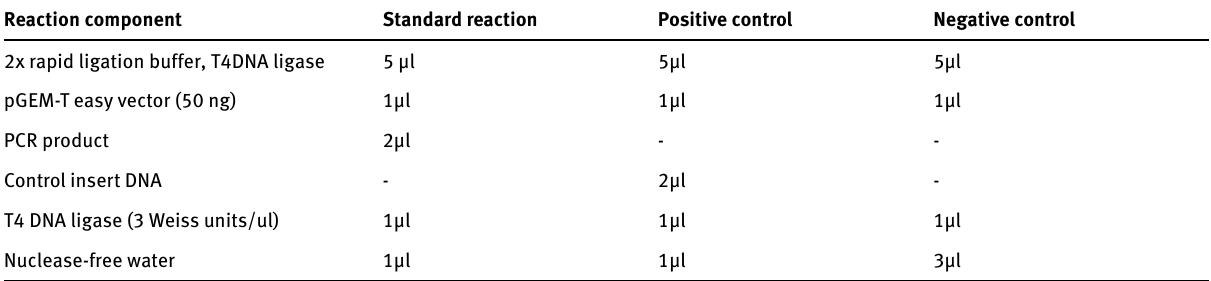
Table 3. Ligation reaction protocol to a final reaction volume of 10ul (pGEM®-T and pGEM®-T Easy Vector Systems Technical